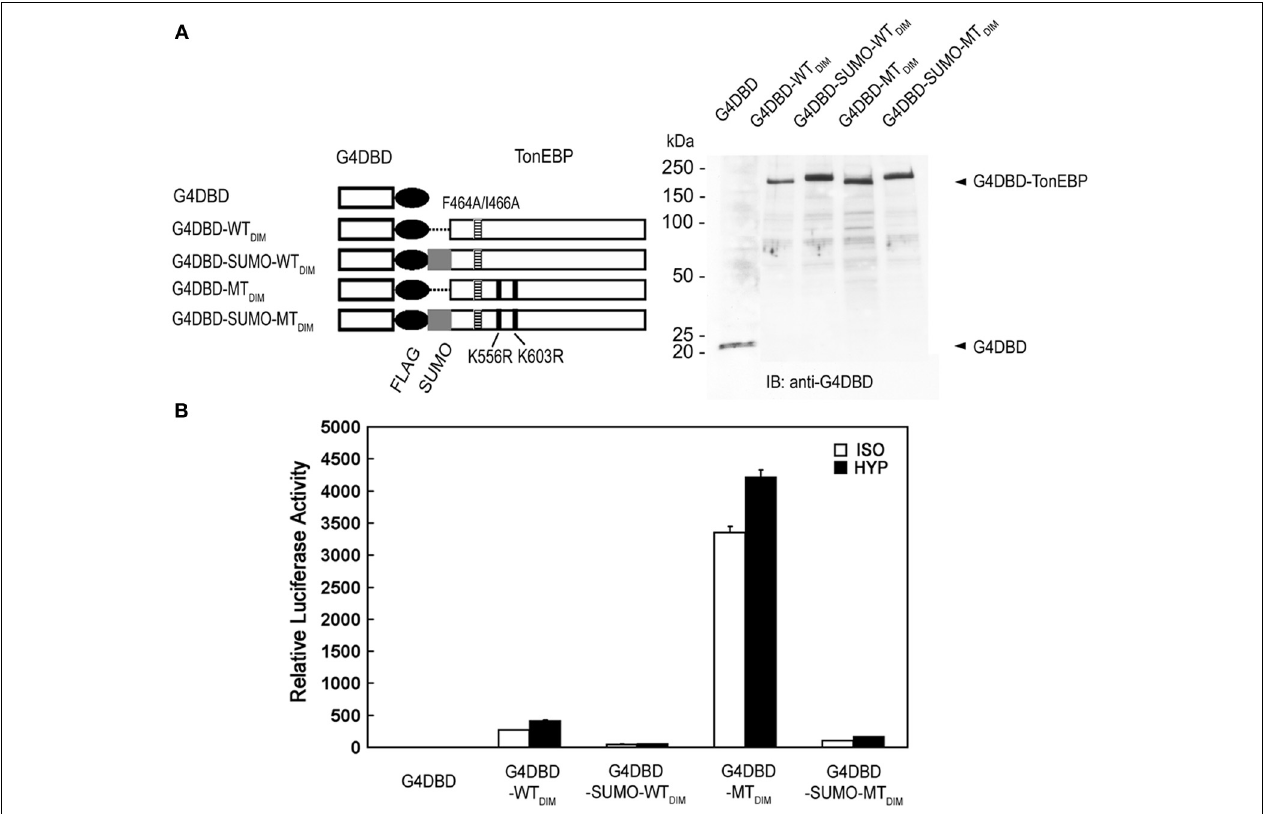
FIGURE 8 | Effects of sumoylation on the transactivation of TonEBP. (A) Left: The DNA binding domain of Gal4 (G4DBD) was fused to the TonEBP constructs shown in Figure 5 except that F464A/I466A mutations (indicated by “ DIM ”) were introduced to prevent dimer formation. Right: The constructs were individually transfected into HEK293 cells and immunoblotted for G4DBD. (B) HEK293 cells were